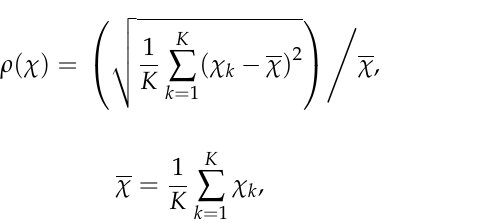
Figure 4. Experimental Assessment. ( V = 8, f 0 = 900 MHz, (cid:101) ε B = 41.8 ε 0 − j 0.97 S = 48.63 ε − j 1.28 )—Coefficient of variation of the ( a ) real and ( b ) imaginary parts of the (cid:101) ε 0 H 2 π f 0